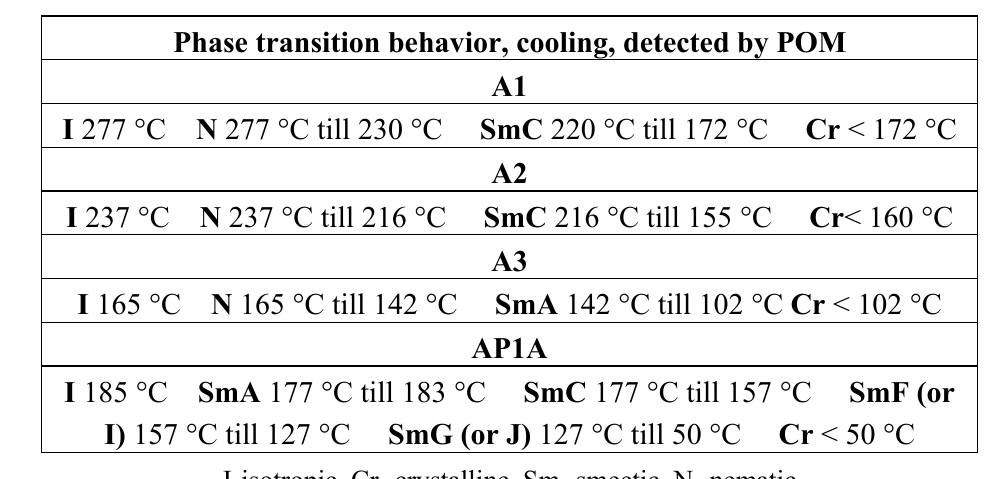
Table 1. Identified mesophases and thermal parameters of the azomethines determined by